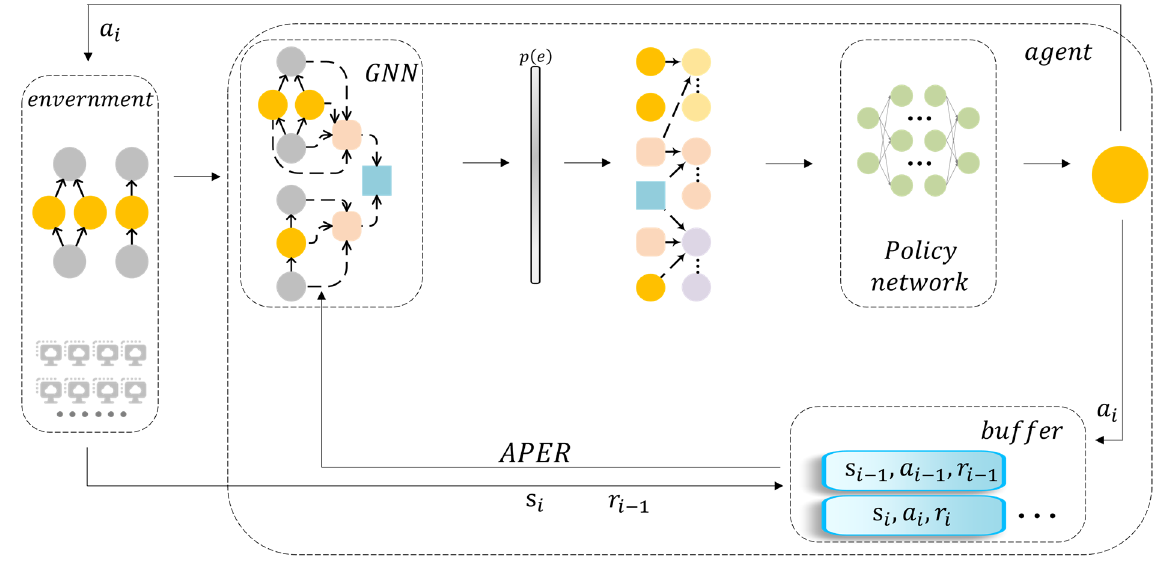
Figure 2. Model framework.